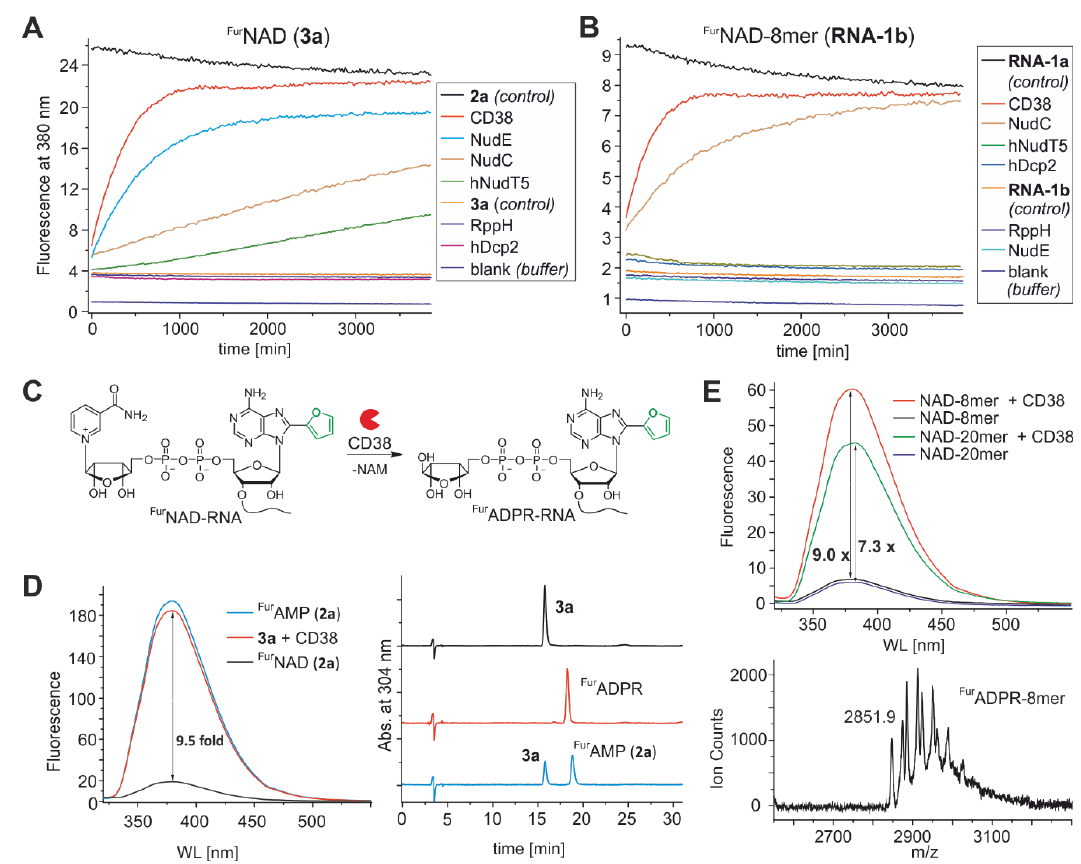
Figure 5. Identification and characterisation of novel decapping enzymes using Fur NAD and Fur NAD-RNAs. Different enzymes were tested for their activity on ( A ) Fur NAD ( 3a , 4.5 µM) and ( B ) Fur NAD-8mer ( RNA-1b , 4.5 µM). Fluorescence time course measurements were performed using a microplate reader (λ exc 304 nm/em 380 nm). ( C ) Schematic representation of the conversion of Fur NAD-RNAs into Fur ADPR-RNAs by CD38. ( D ) Comparison of fluorescence intensities and HPLC analysis of the reaction of CD38 (2.5 nM) with Fur NAD after 45 min reaction; retention times of 3a (15.8 min), Fur ADPR (18.2 min), 2a (18.8 min) (Phenomenex Luna 5u, 25 × 4.6 mm, 1 mL/min, 5–15% buffer B in 30 min). ( E ) Immediate fluorescence turn-on after addition of CD38 (50 nM) to 5’- Fur NAD-RNAs (each 4.5 µM; 8mer-, RNA-1b , 20mer-, RNA-2b ) and corresponding MALDI-MS of Fur ADPR-8mer: calculated m/z: 2852.36. Corresponding HPLC chromatograms are shown in Figure S13.